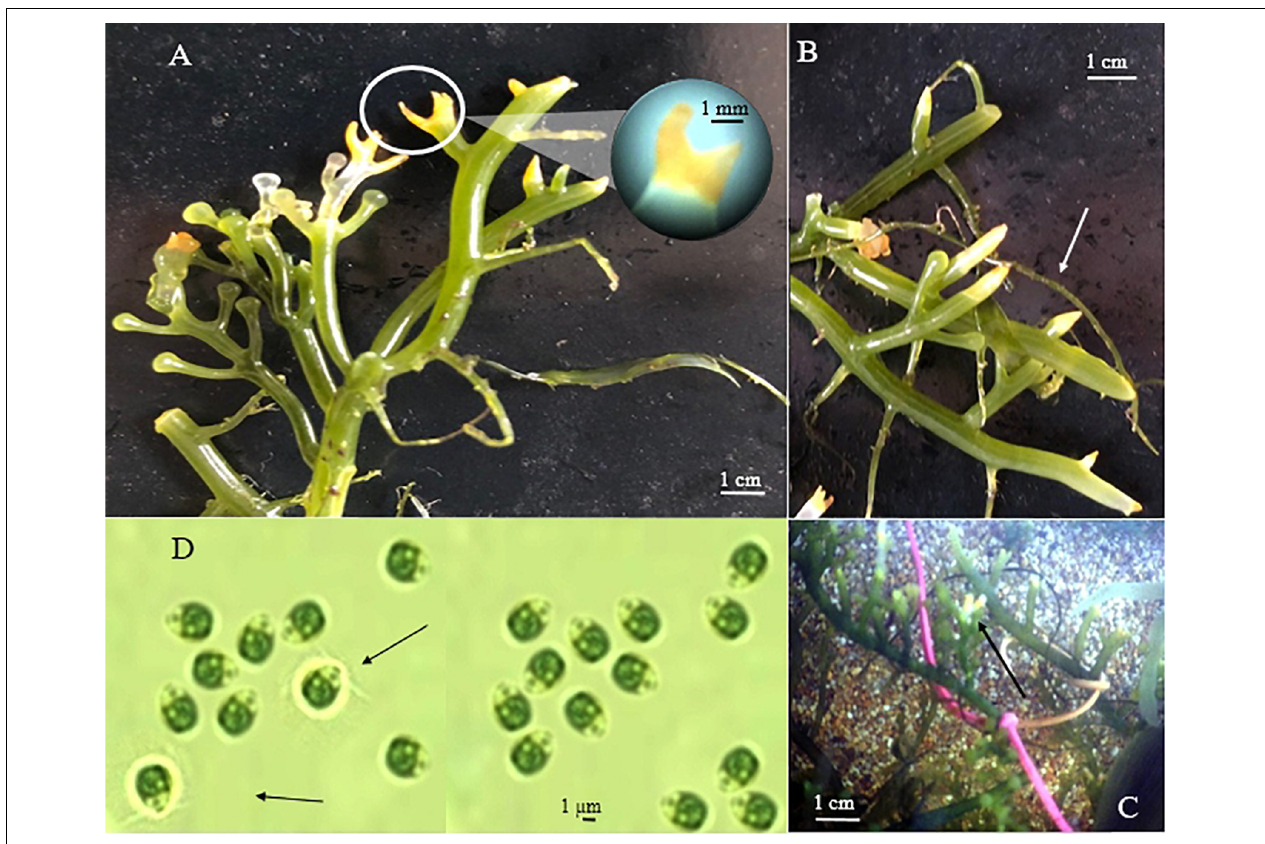
FIGURE 3 | (A–C) Fertile depigmented thalli with papillae in aquaria (A,B) and directly in the field (C) . (C,D) A particular colored branchlet is presented in (A) , while several discharge tubes are visible in (B,D) , the observed gametes with and without